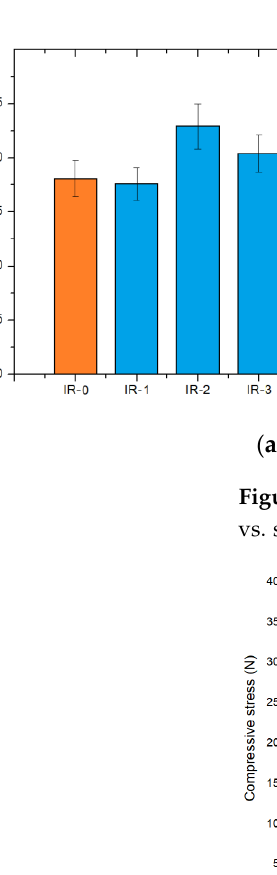
Figure 14. Failure photos of the IR- series samples: ( a ) IR-2, ( b ) IR-6, and ( c ) IR-1. Few researchers have investigated the compressive strength improvement among the studies on the inner reinforcement and across the interfaces. Marchment and Sanjayan [39] conducted compressive experiments vertically to the printing direction, as shown by the Y -axis in Figure 8e, and found that the printed sample was 33% lower than the cast samples in the bar-penetrating reinforcement. For the studies with the same loading direction described herein [Figure 8f], Li and Wang [13] carefully designed the printing paths to spiral-spread the embedded-cables and increased the compressive strength by 50%; Liu and Zhang [32] placed wire meshes be- tween the layers to improve the compressive strength by 75%. The spiraled-cables and placed-meshes enhanced the compressive strength by limiting the material extension. This study achieved a maximum compressive improvement of 18.3% at a volume fraction